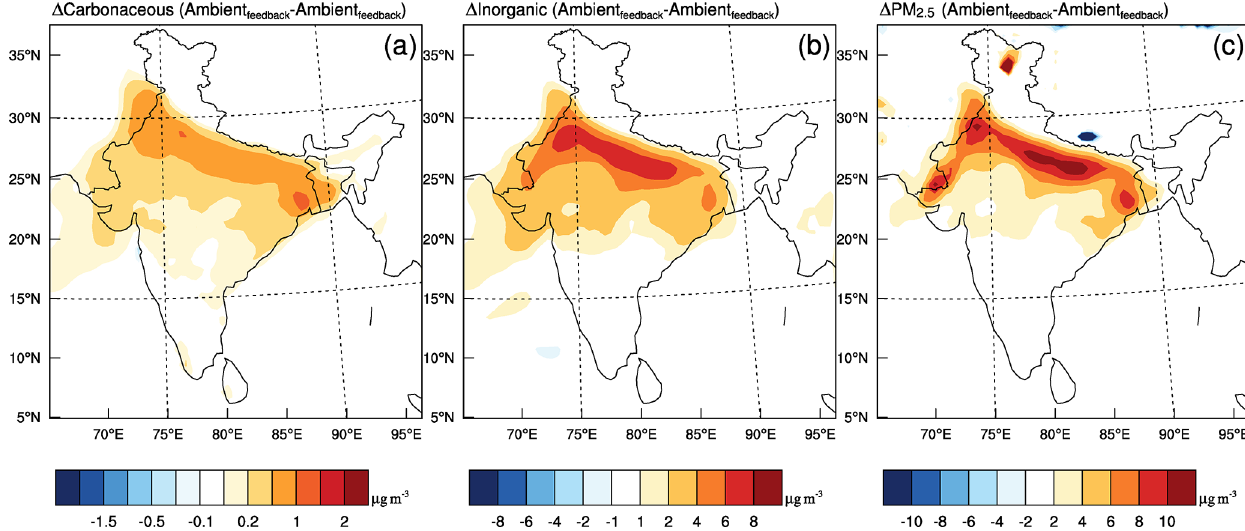
Figure 10. Change in near-surface mass loading (µgm − 3 ) due to the meteorological feedback of total aerosol radiative forcing for (a) car- bonaceous aerosols, (b) inorganic aerosols and (c) PM 2 . 5 .